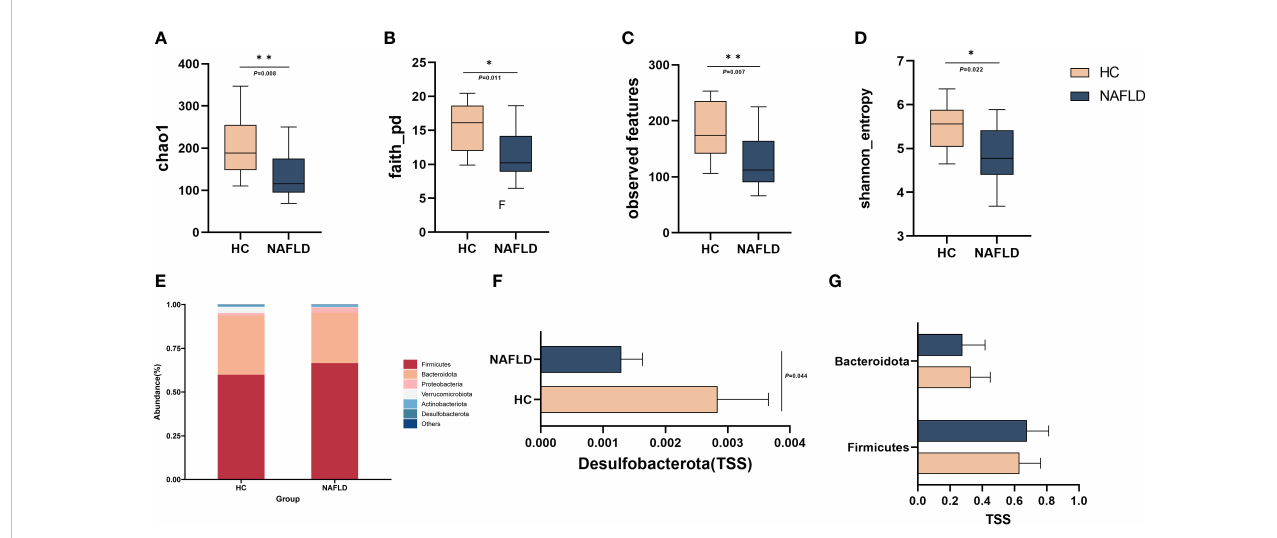
FIGURE 4 Reduced species diversity and altered intestinal fl ora abundance were observed in NAFLD. (A-D) Comparison of intestinal fl ora alpha diversity in HC and NAFLD. (E) The abundance percentages of HC and NAFLD groups at the phylum level. (F) Comparison of the abundance of Desulfobacterota in the phylum level. (G) Comparison of the abundance of Firmicutes and Bacteroidetes in the phylum level. TSS, Total-sum normalization. * P < 0.05 and ** P <